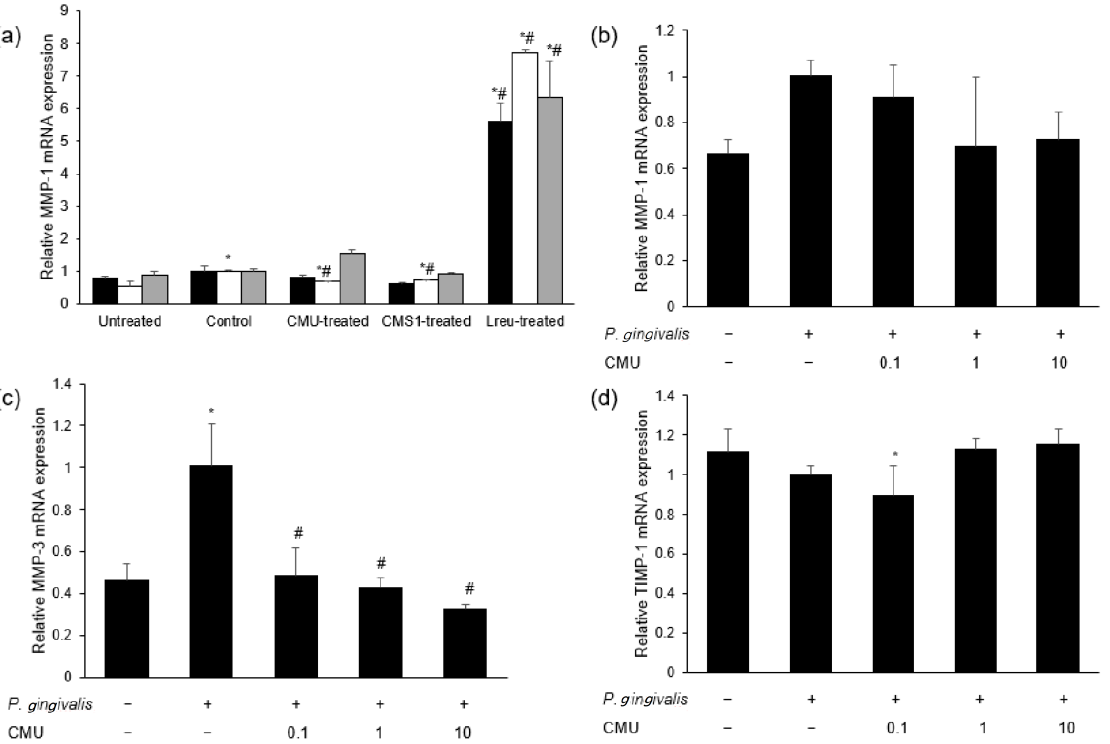
Figure 6. Effects of oral probiotics on the expression of MMPs ( a – c ) and TIMP-1 ( d ) induced by periodontopathogens. ( a ) Comparison of the effects of oral probiotics on the mRNA expression of MMP-1. Black bar, P. gingivalis ; white bar, F. nucleatum ; gray bar, P. intermedia; CMU, W. cibaria CMU; CMS1, W. cibaria CMS1; Lreu, L. reuteri . ( b – d ) Dose-dependent effects of W. cibaria CMU on the mRNA expression of MMP-1, MMP-3, and TIMP-1 induced by P. gingivalis. HGFs were pre-treated with W. cibaria CMU for 30 min at various doses (0.1, 1, and 10) and then incubated with P. gingivalis for 4 h. Data are presented as the mean ± standard deviation. * p < 0.05, compared to the untreated group. # p < 0.05, compared to the control group.